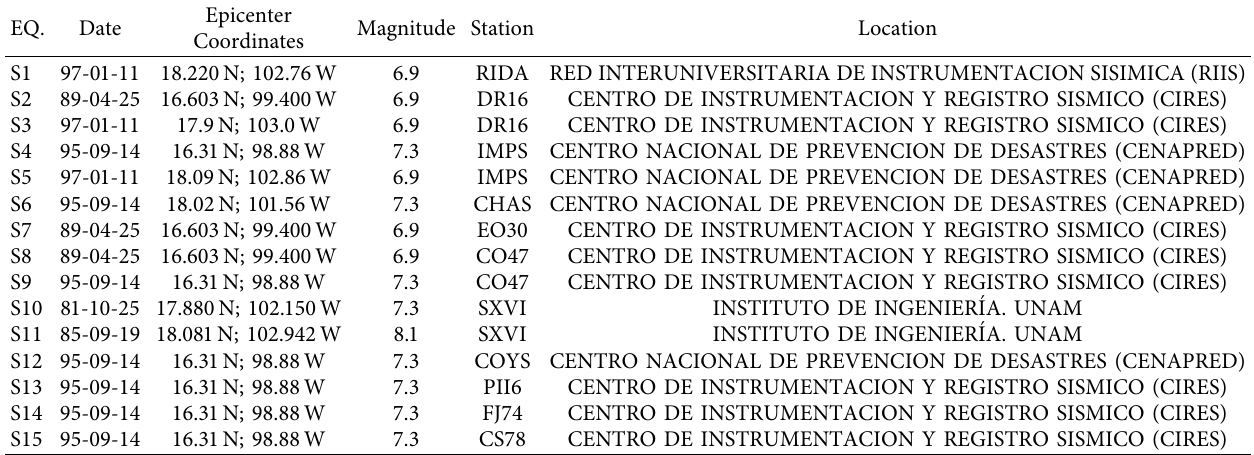
Table 2: Earthquake ground motions recorded on soft soil Ts � 2.0s in Mexico City.